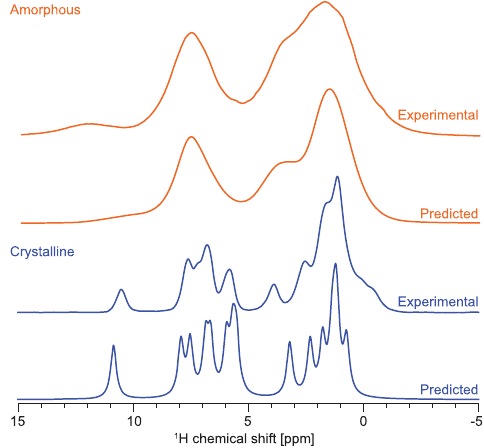
Fig. 3 Predicted spectra. Predicted and experimental 1 H NMR spectra of crystalline (blue) and amorphous (orange) 1 . The predicted spectrum of amorphous 1 was obtained by considering only the 4% w/w water MD